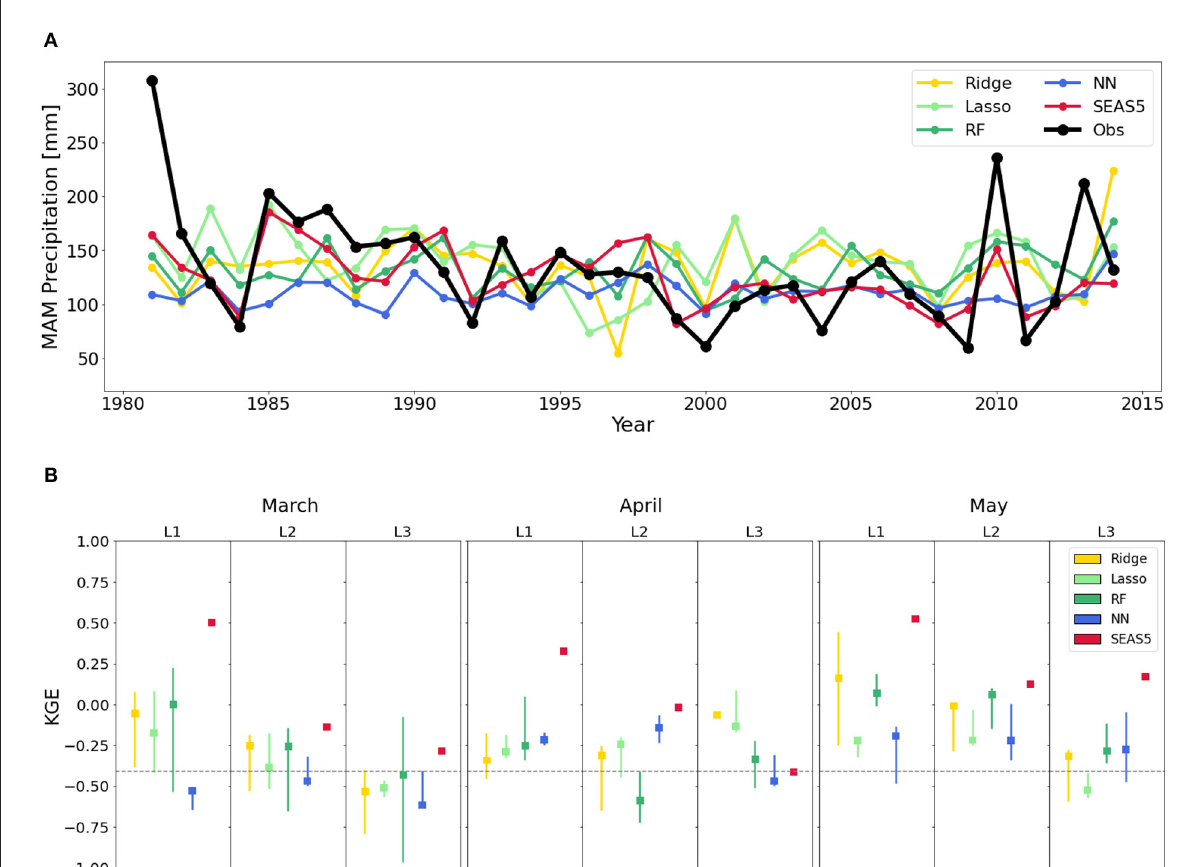
FIGURE4 Performance of the A2 approach for predictor selection where independent test data is used that is not employed in the preselection of correlated predictors. (A) Time series of observations and hindcasts of the nested cross-validation procedure of all modeling methods for MAM at a 1-month lead-time representing the second approach where correlations are performed inside the cross-validation loop, excluding the years used for testing (A2). (B) Median and interquartile ranges illustrating the Kling–Gupta Efficiency (KGE) performances of the cross-validation procedure for the four data-driven models and the dynamical hindcast at all lead-times (L1–L3). RF and NN refer to the random forest and the single-layer neural network, respectively. KGE-values > − 0.41 (see discontinuous line) indicate some skill compared to using the climatological mean as